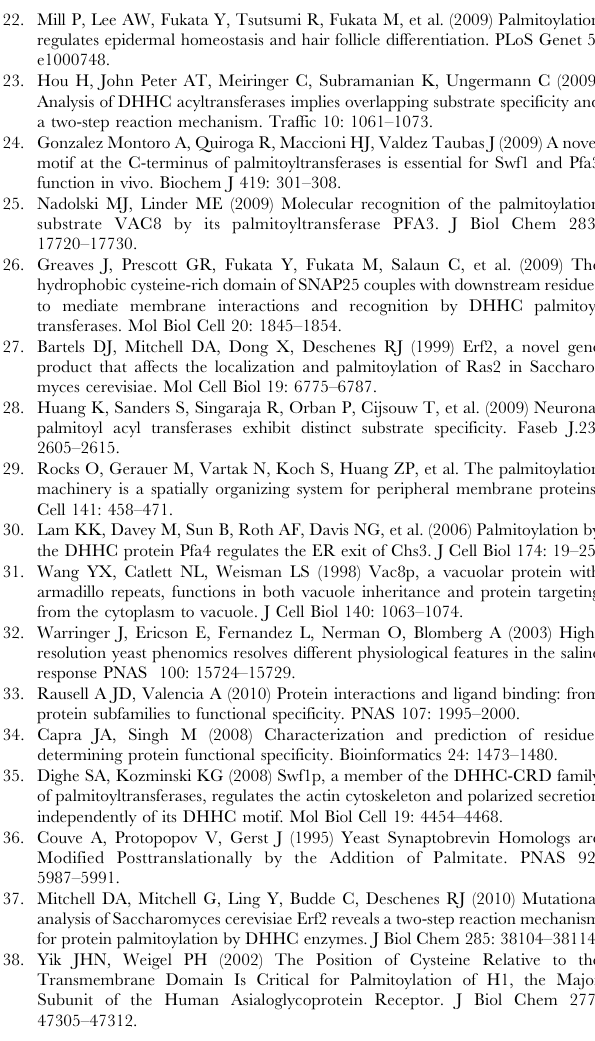
Table S1 List of oligonucleotides used troughout this